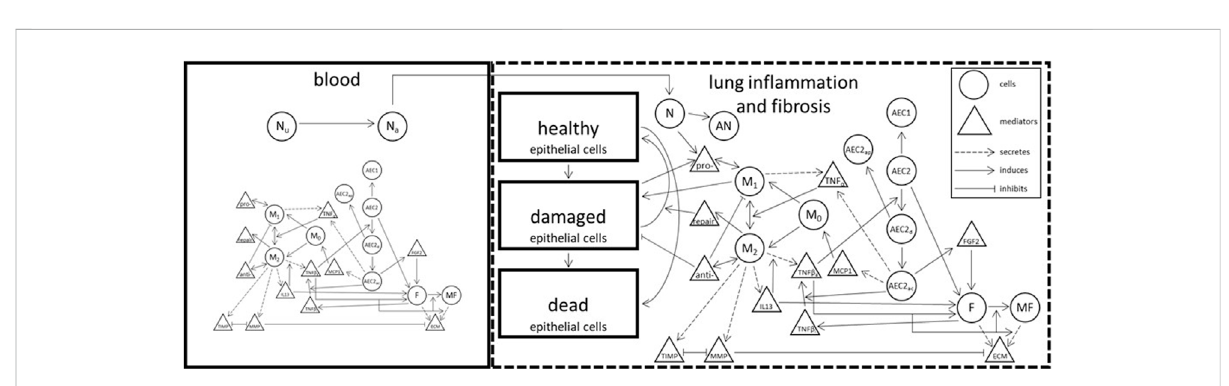
FIGURE 4 Abstract representation of model including all interactions [modi fi ed from (Cogo et al., 2007; Minucci et al.,